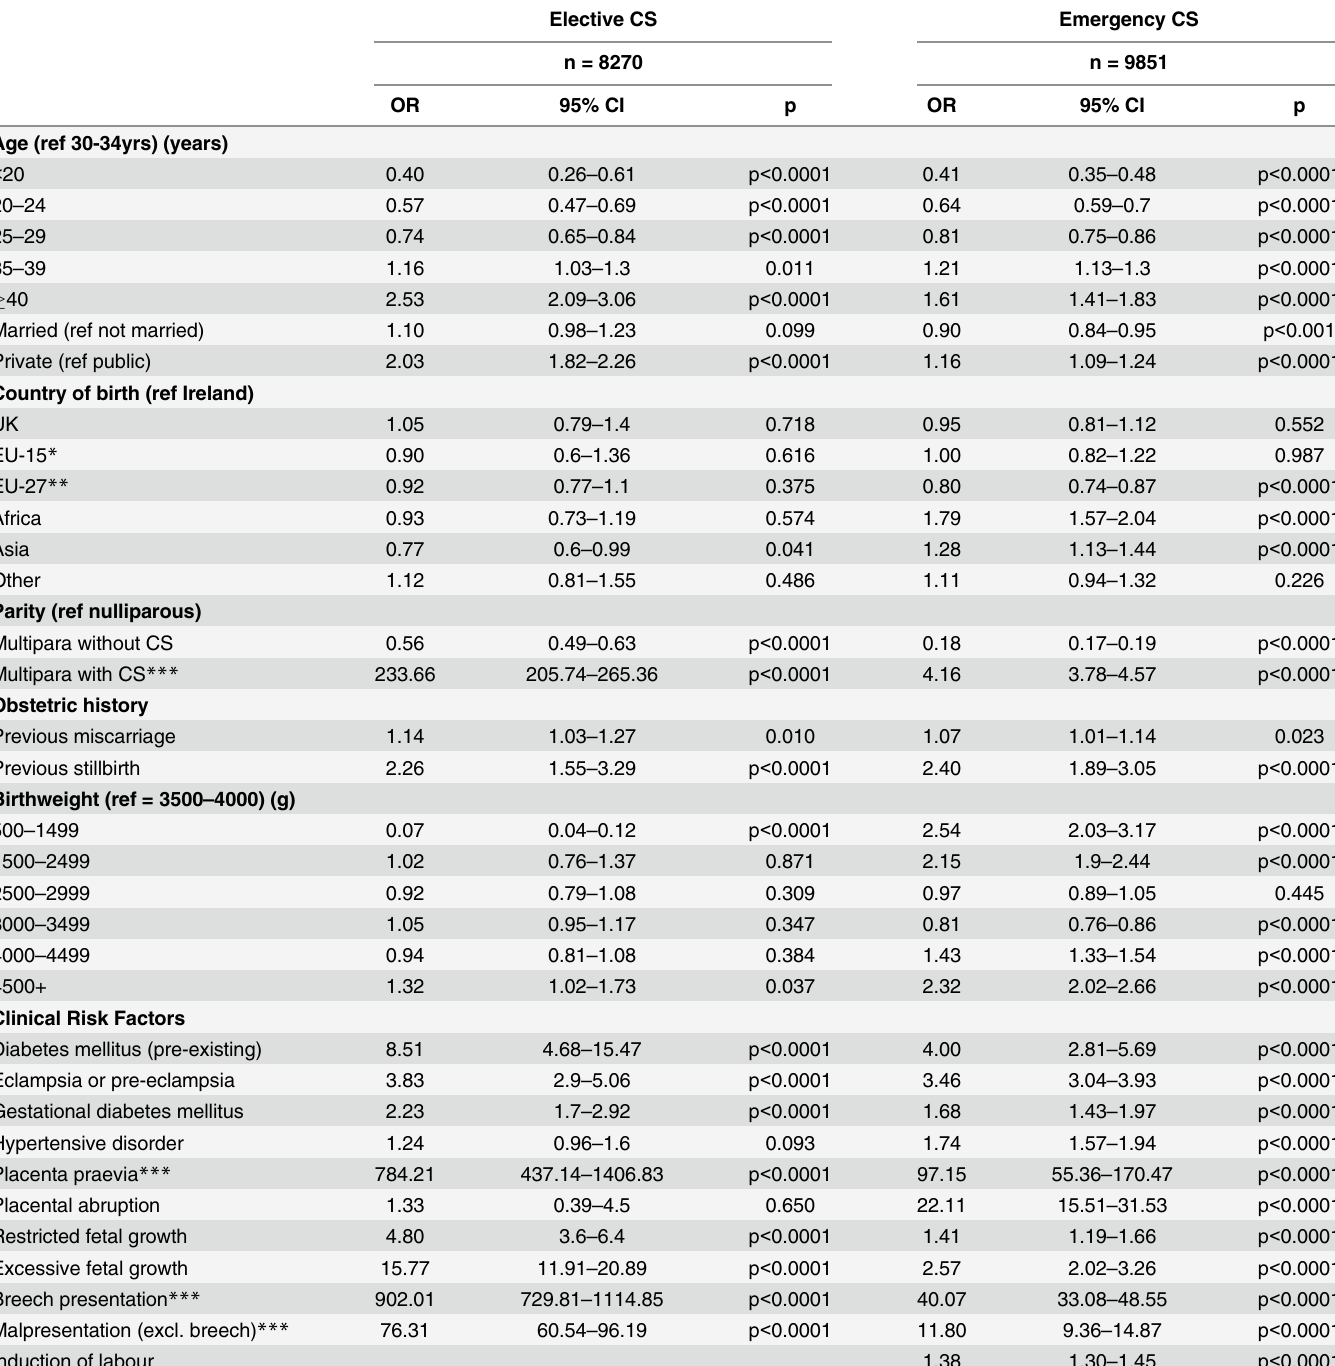
Table 2. Odds of caesarean section across all 19 publicly funded hospitals adjusted by individual level sociodemographic and organisational